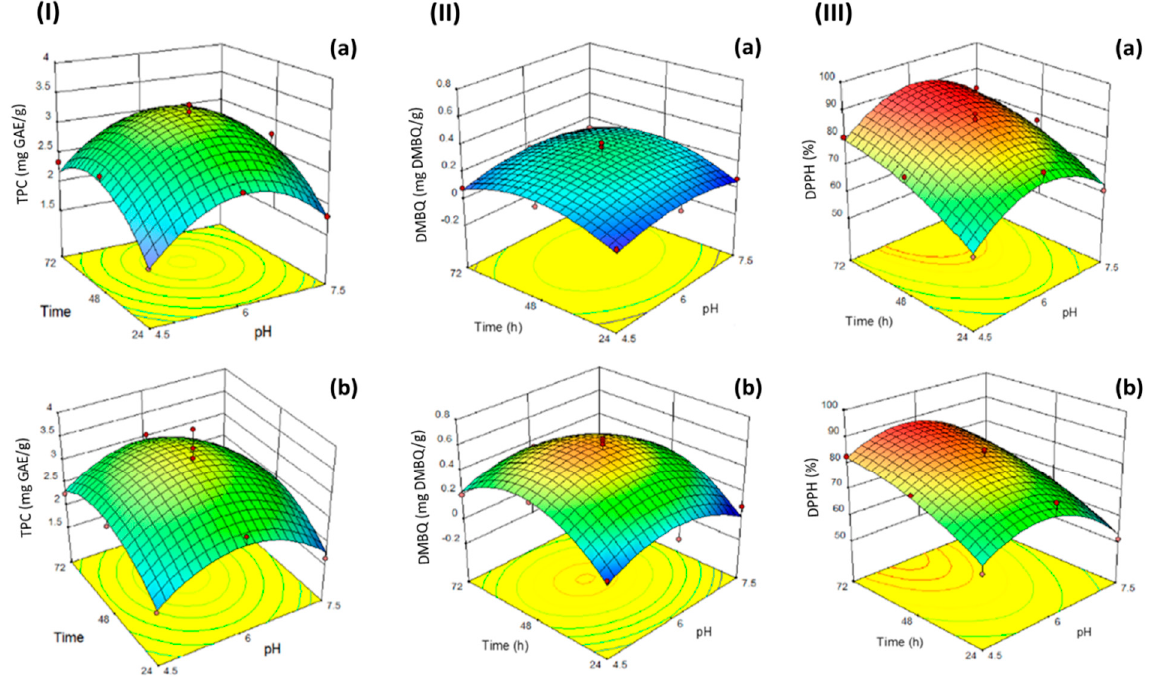
Figure 1. Contour plots (2D) and response surface plots (3D) of the effect of pH and fermentation times on the ( I ) TPC (mg gallic acid equivalents (GAE)/g freeze-dried sample), ( II ) DMBQ contents (mg DMBQ/g freeze-dried sample) and ( III ) DPPH (%) of wheat germ samples following a fermentation process using either: ( a ) yeast ( S . cerevisiae ) or ( b ) bacteria ( L. plantarum ).